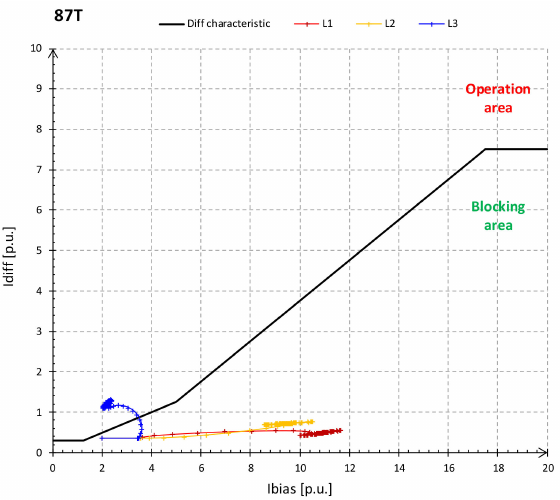
Figure 21. Differential and stabilization current